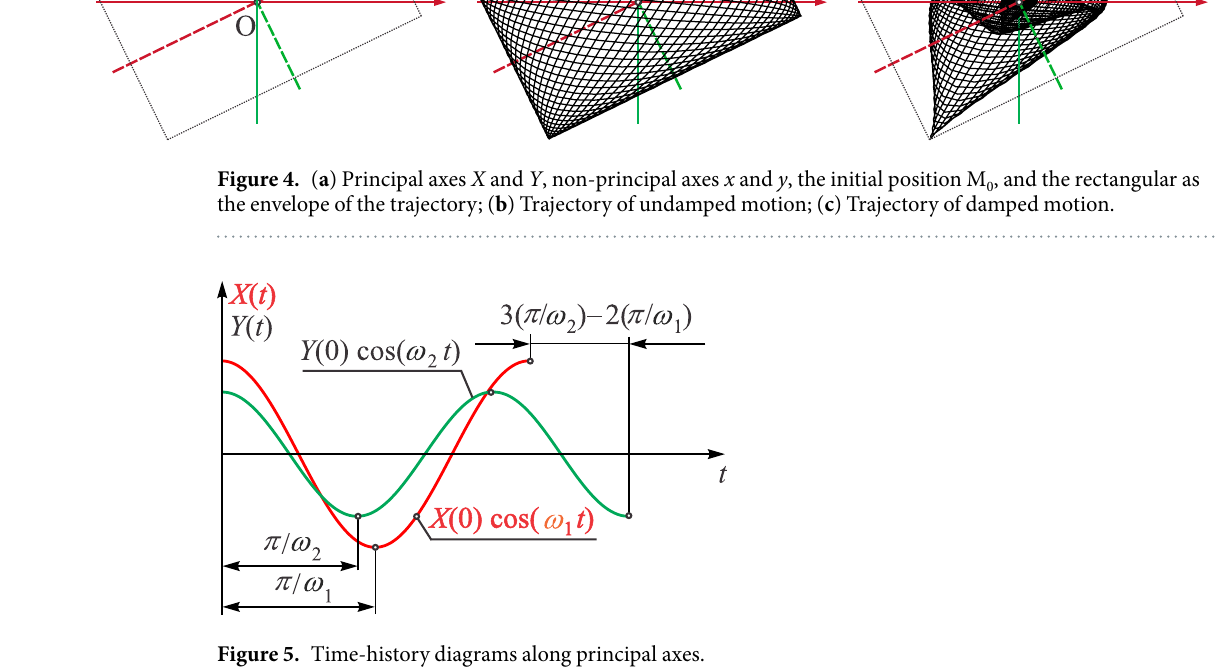
Figure 5. Time-history diagrams along principal axes.